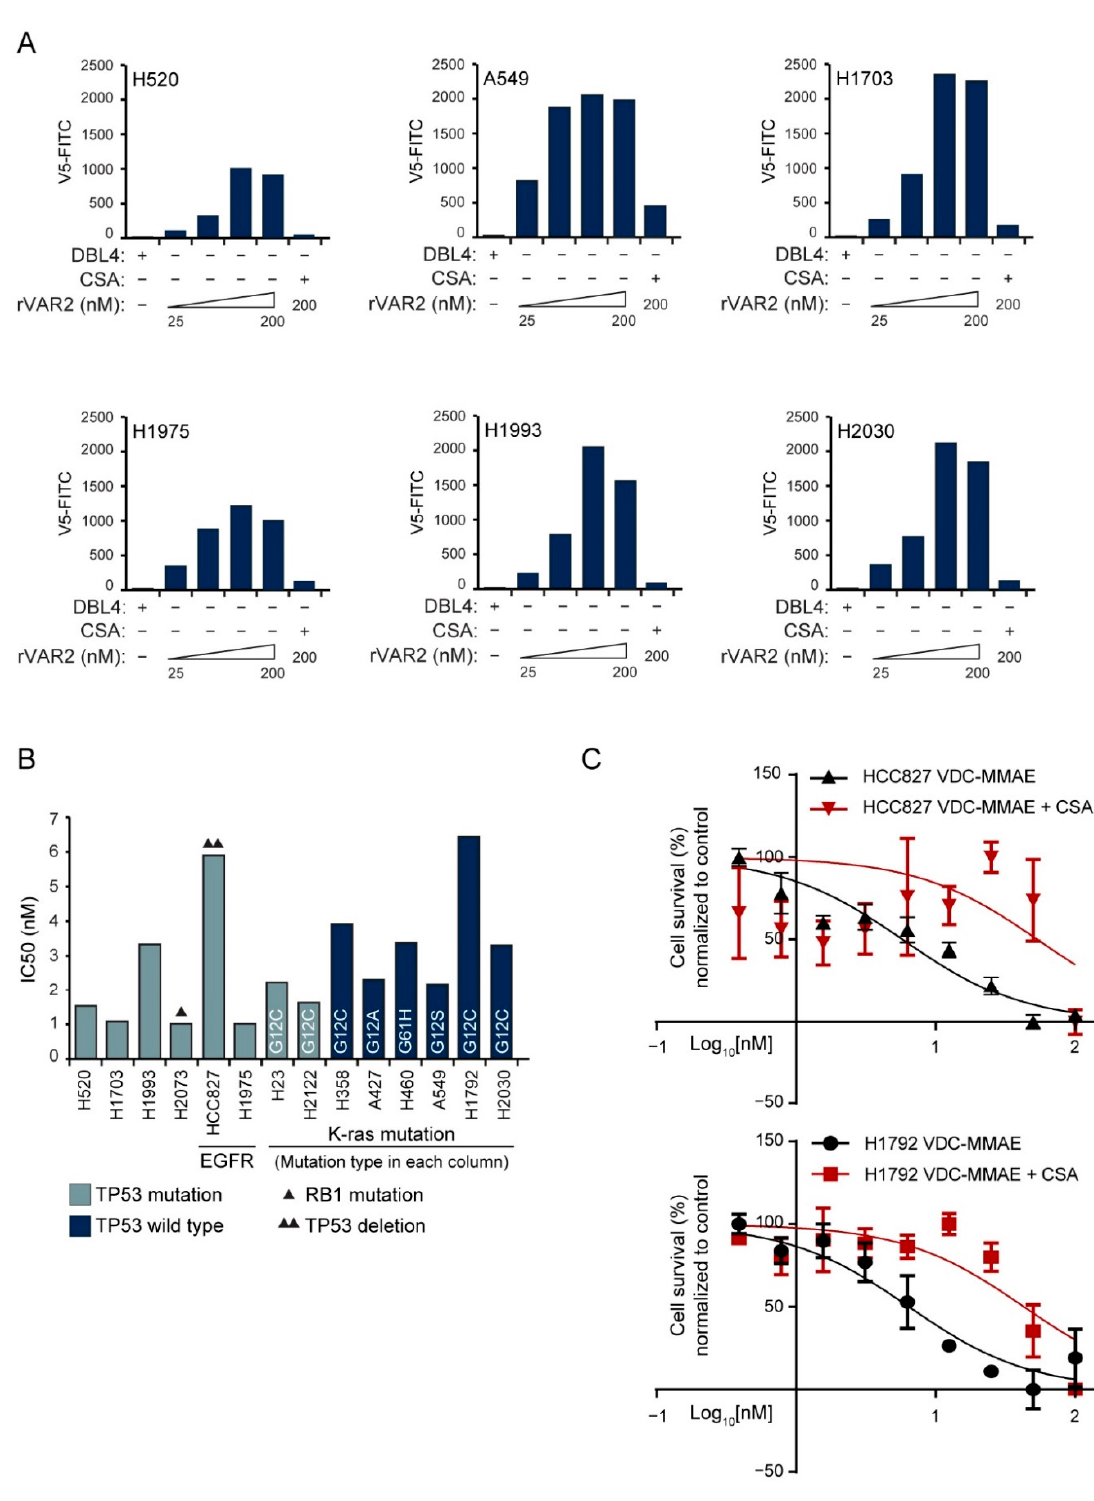
Figure 2. The rVAR2 binding and VDC killing assay: ( A ) relative mean fluorescence intensity (MFI) of lung cancer cells, incubated with recombinant control protein (DBL4) or VAR2CSA (rVAR2) as indicated, and detected by flow cytometry using anti-V5-FITC; ( B ) the column graph displays IC50 kill values of VDC-MMAE compound on 14 lung cancer cell lines. Types of KRAS mutation are provided in the column of each cell line; ( C ) VDC-MMAE killing assay with and without CSA competition in two NSCLC cell lines; HCC827 (upper panel) and H1792 (lower panel). Abbreviations: rVAR2: recombinant malaria protein VAR2CSA; VAR2CSA: variant surface antigen 2-CSA; VDC: rVAR2 drug conjugate; CSA: chondroitin sulfate A; MMAE: monomethyl auristatin E; FITC: fluorescein isothiocyanate; IC50: inhibitory concentration 50.